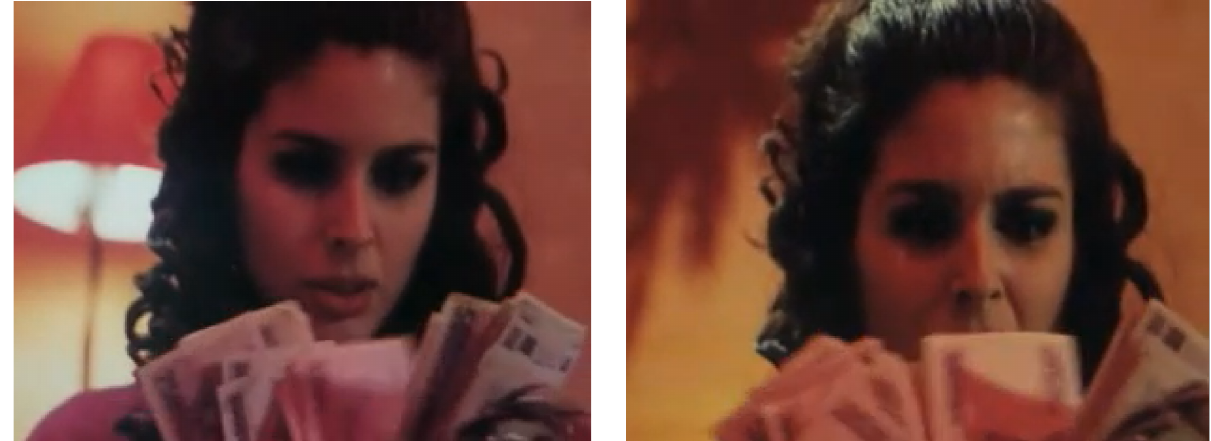
Figure 8-9: Serap ambitiously counts money she